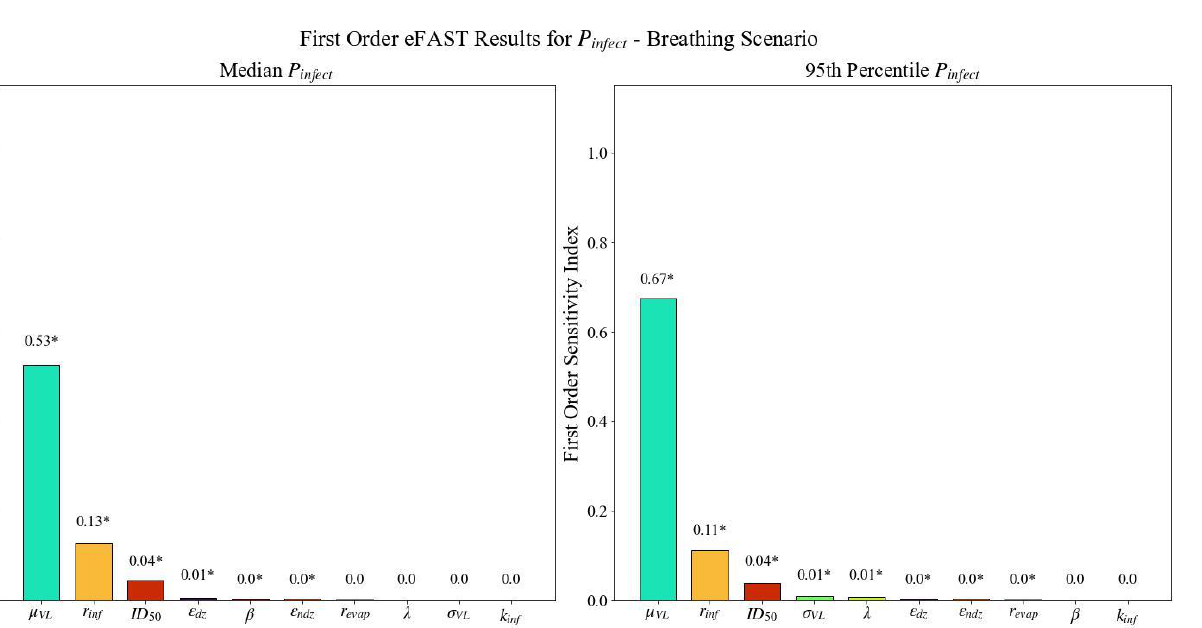
Figure A7 . First-order sensitivity indices (ordered from largest to smallest) derived using eFAST for the median 𝑃 𝑖𝑛𝑓𝑒𝑐𝑡 and 95th percentile of 𝑃 𝑖𝑛𝑓𝑒𝑐𝑡 with coughing as the emission mechanism. Asterisks (*) indicate statistically significant sensitivity indices ( 𝛼 = 0.01 ).